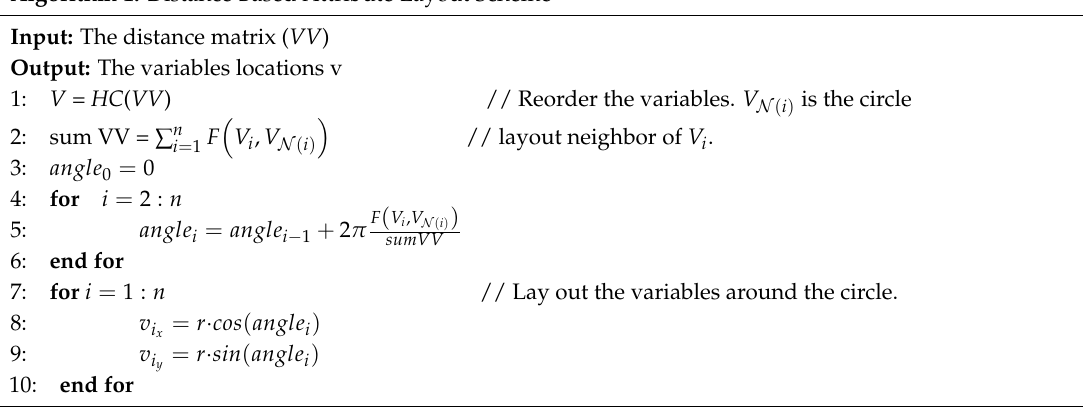
Algorithm 1. Distance Based Attribute Layout